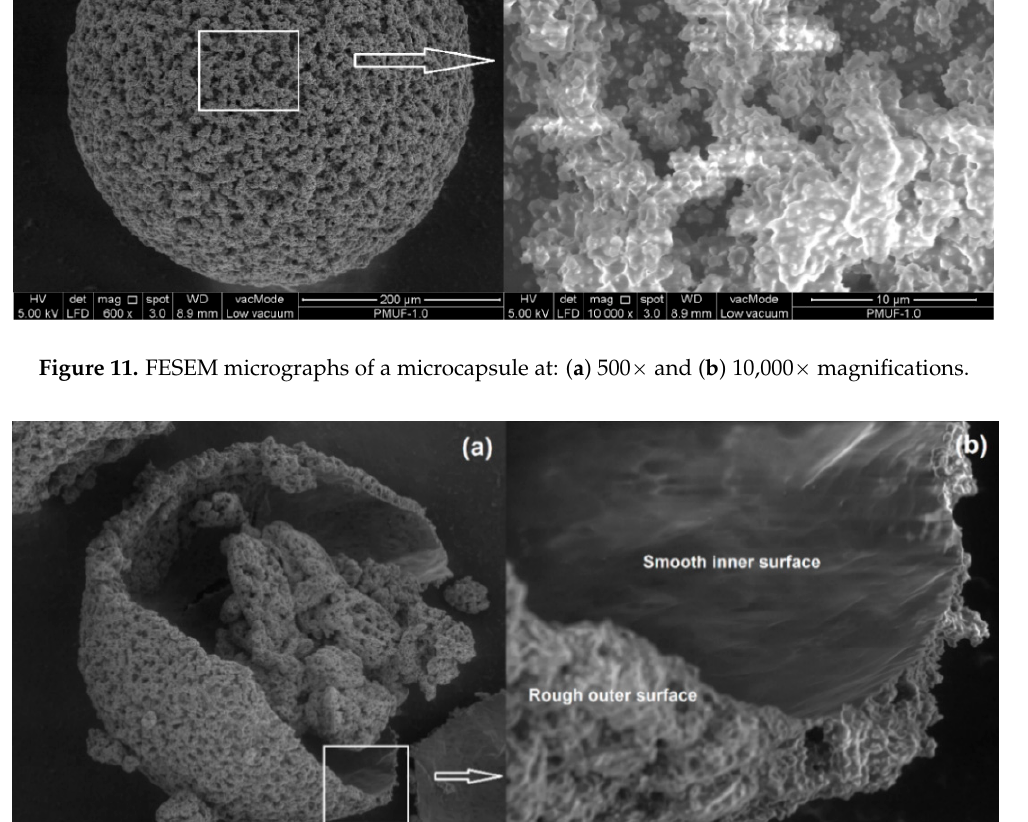
Figure 12. FESEM micrograph of a ruptured microcapsule at: ( a ) 500×; and ( b ) 4000× magnifications.